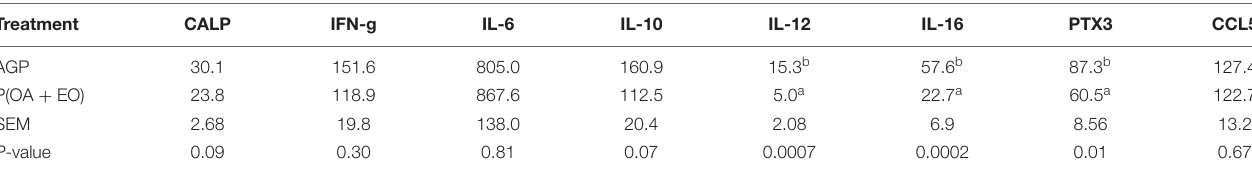
FIGURE 1 | Histopathological analysis by score (A) and total (B) of the jejunum of broiler chickens supplemented with antibiotic growth promoter (AGP) or protected organic acids (OA) and essential oils (EO) [P(OA + EO)] raised under field conditions. Values are means of 40 replicates. Inf, inflammatory [ ± standard error of mean (SEM); ab P < 0.05].